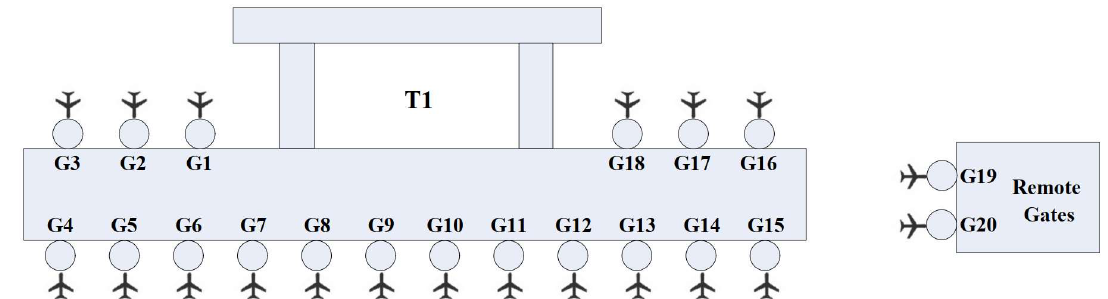
Figure 3. Layout of Terminal 1 in Shanghai Pudong International Airport.